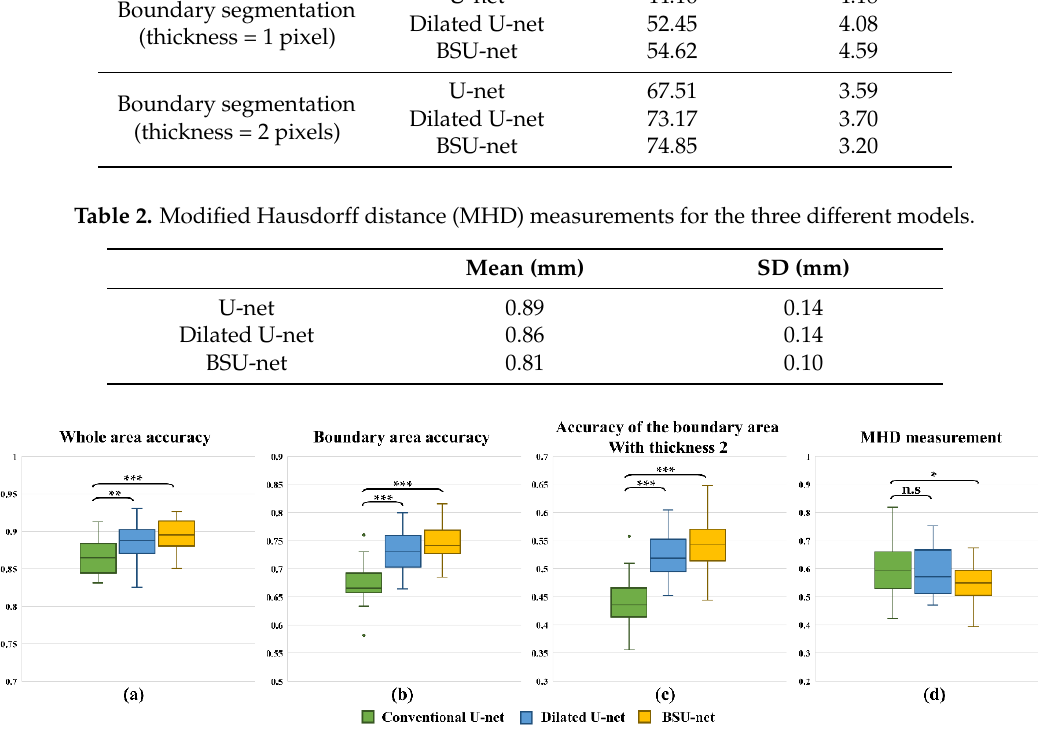
Figure 5. Segmentation results of networks. ( a ) Dice coefficients for whole area of intervertebral discs. ( b ) Dice coefficients of the boundaries of intervertebral discs whose thickness is defined as 1 pixel. ( c ) Dice coefficients of the boundaries of intervertebral discs whose thickness is defined as 2 pixels. ( d ) MHDs of intervertebral discs. A paired t -test was performed to calculate p -values. * denotes p < 0.05, ** denotes p < 0.01, *** denotes p < 0.001, and n.s. denotes not significant ( p > 0.05 ).